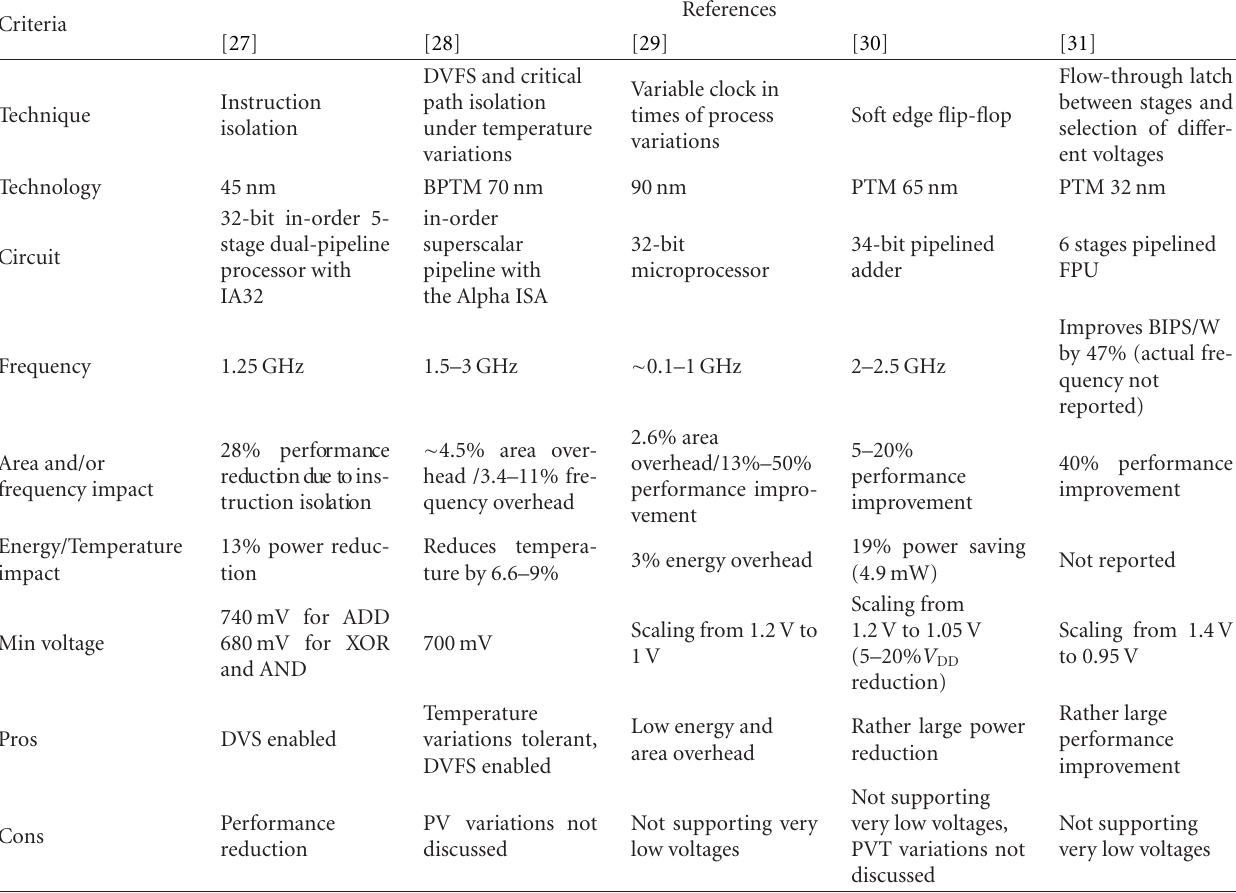
Table 3: Comparison of pipelining